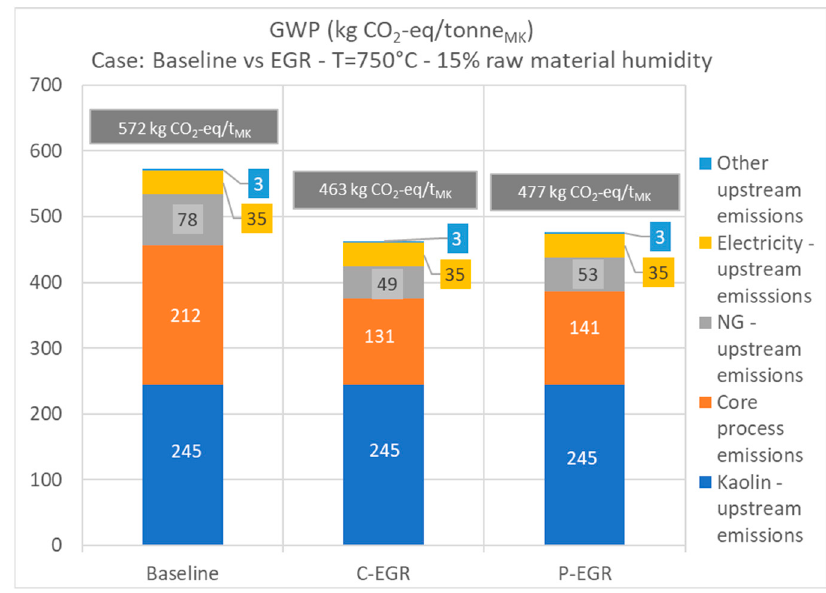
Figure 11. Influence of kaolin humidity on the lifecycle GWP.